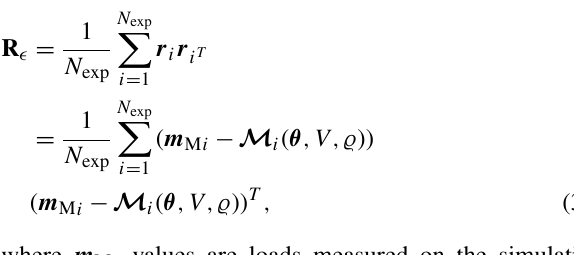
8 ◦ and κ h 0 . 1 (c) , horizontal shear κ h at χ = − = −